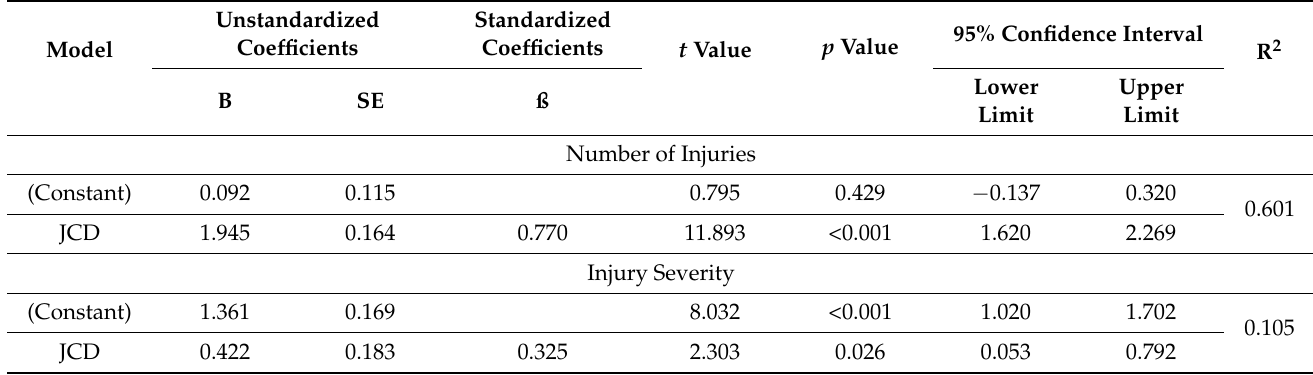
Table 4. Multivariate analysis with number of injuries and injury severity as the dependent variable and joint clearance discrepancy (JCD) as the